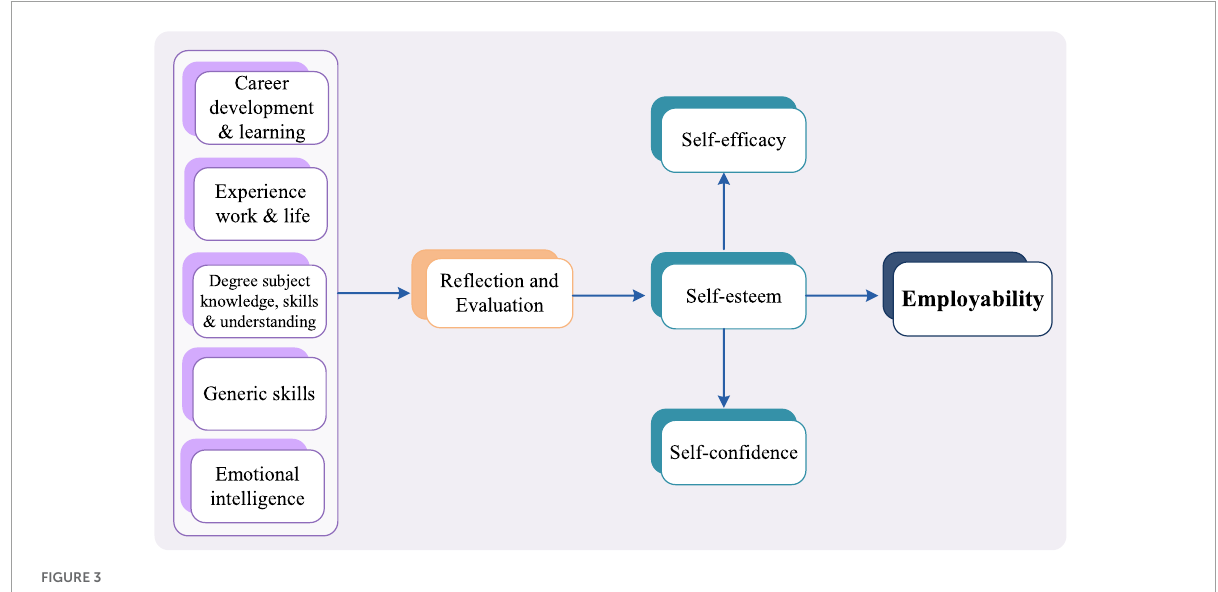
FIGURE3 The career EDGE